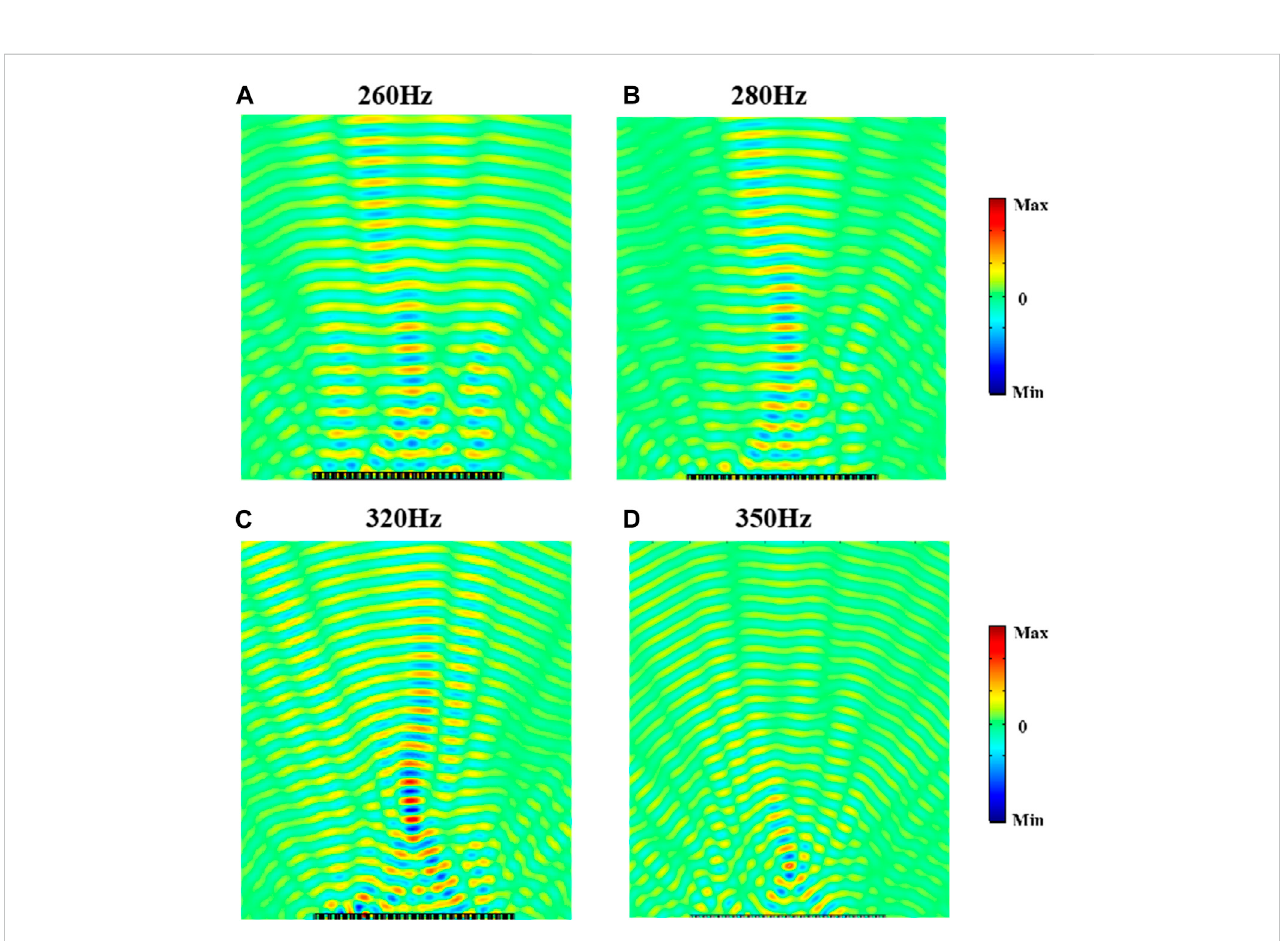
FIGURE 5 Normalized pressure fi eld of the proposed self-bending beam metasurface structure working under different frequencies ( (A – D) for 260 Hz, 280 Hz, 320 Hz and 350 Hz,